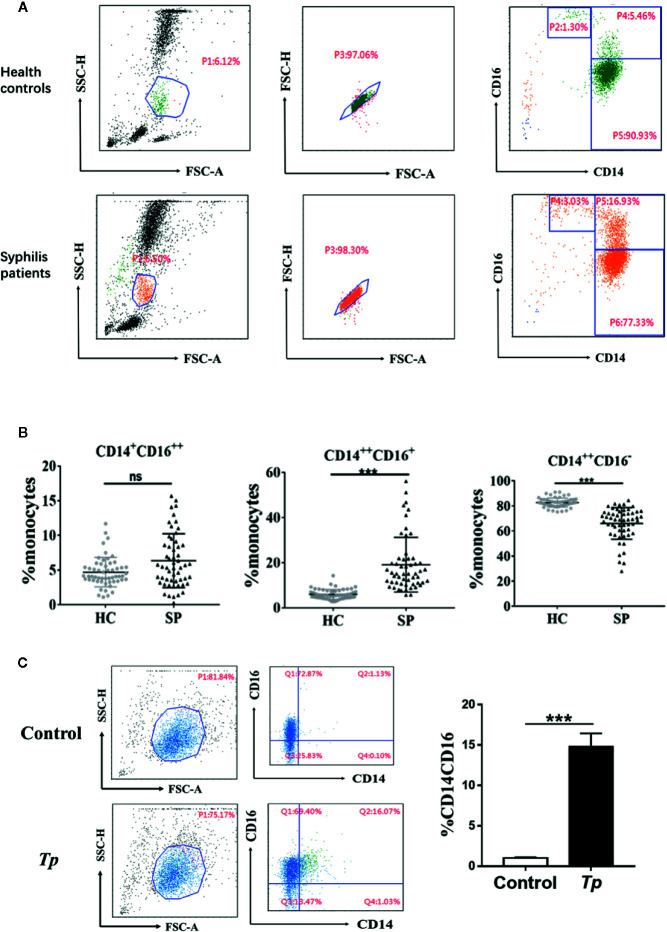
Characteristics of monocyte subsets in syphilis patients and healthy controls. (A) Gating strategy for monocyte subsets. (B) The percentage of each monocyte subset in syphilis patients (n = 55) and healthy controls (n = 55). (C)
Tp promoted the expression of CD14 and CD16 in THP-1 cells. The data in the bar graphs are the means ± SEMs of three separate experiments. ***P < 0.001. FSC, forward scatter; SSC, side scatter; HC, healthy controls; SP, syphilis patient.